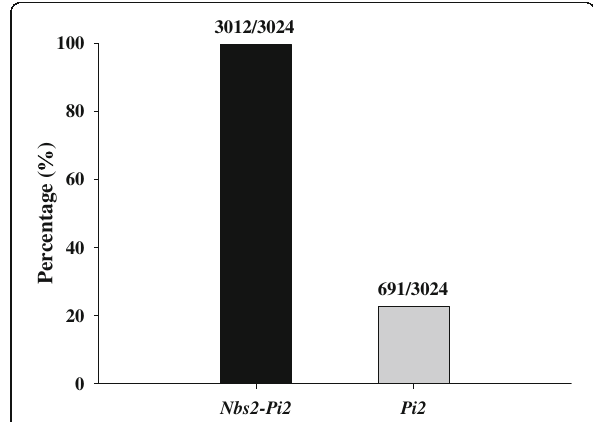
Fig. 1 Frequency of Nbs2-Pi2 and Pi2 alleles in 3024 rice